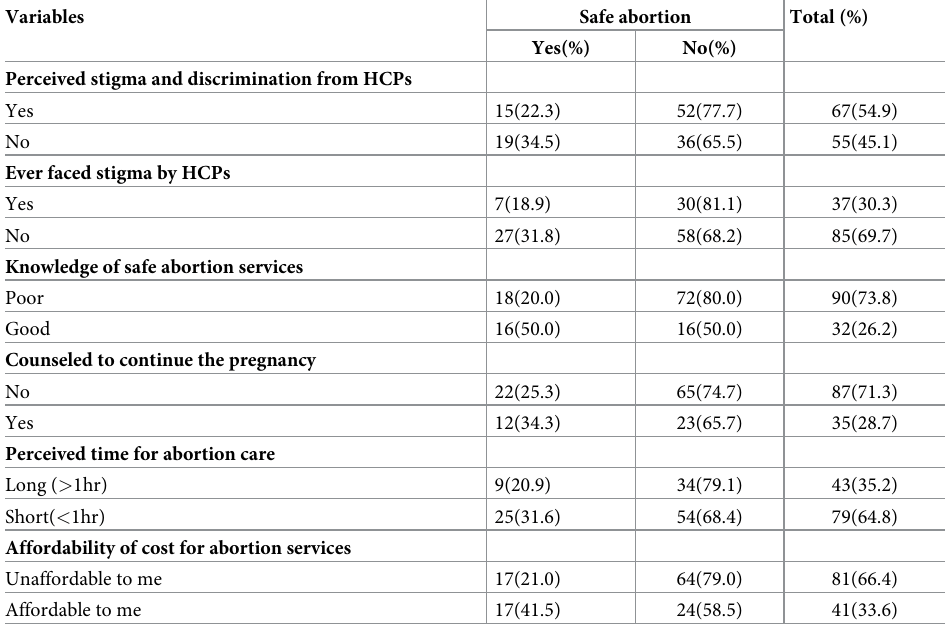
Table 2. Individual and health system-related characteristics of insecurely housed women in southwest Ethiopia, 2021 G.C.